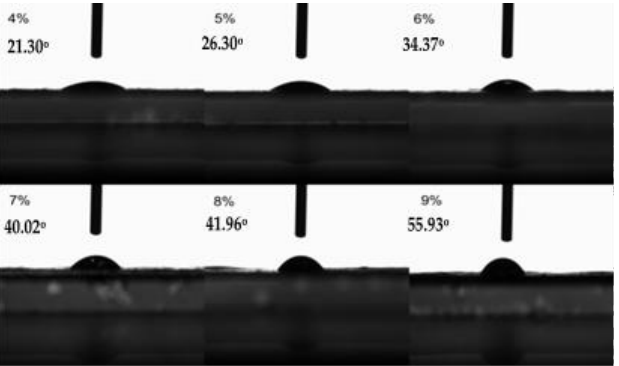
Figure 8. Contact angles of membranes prepared from casting liquid with different jute MCC con- tent.